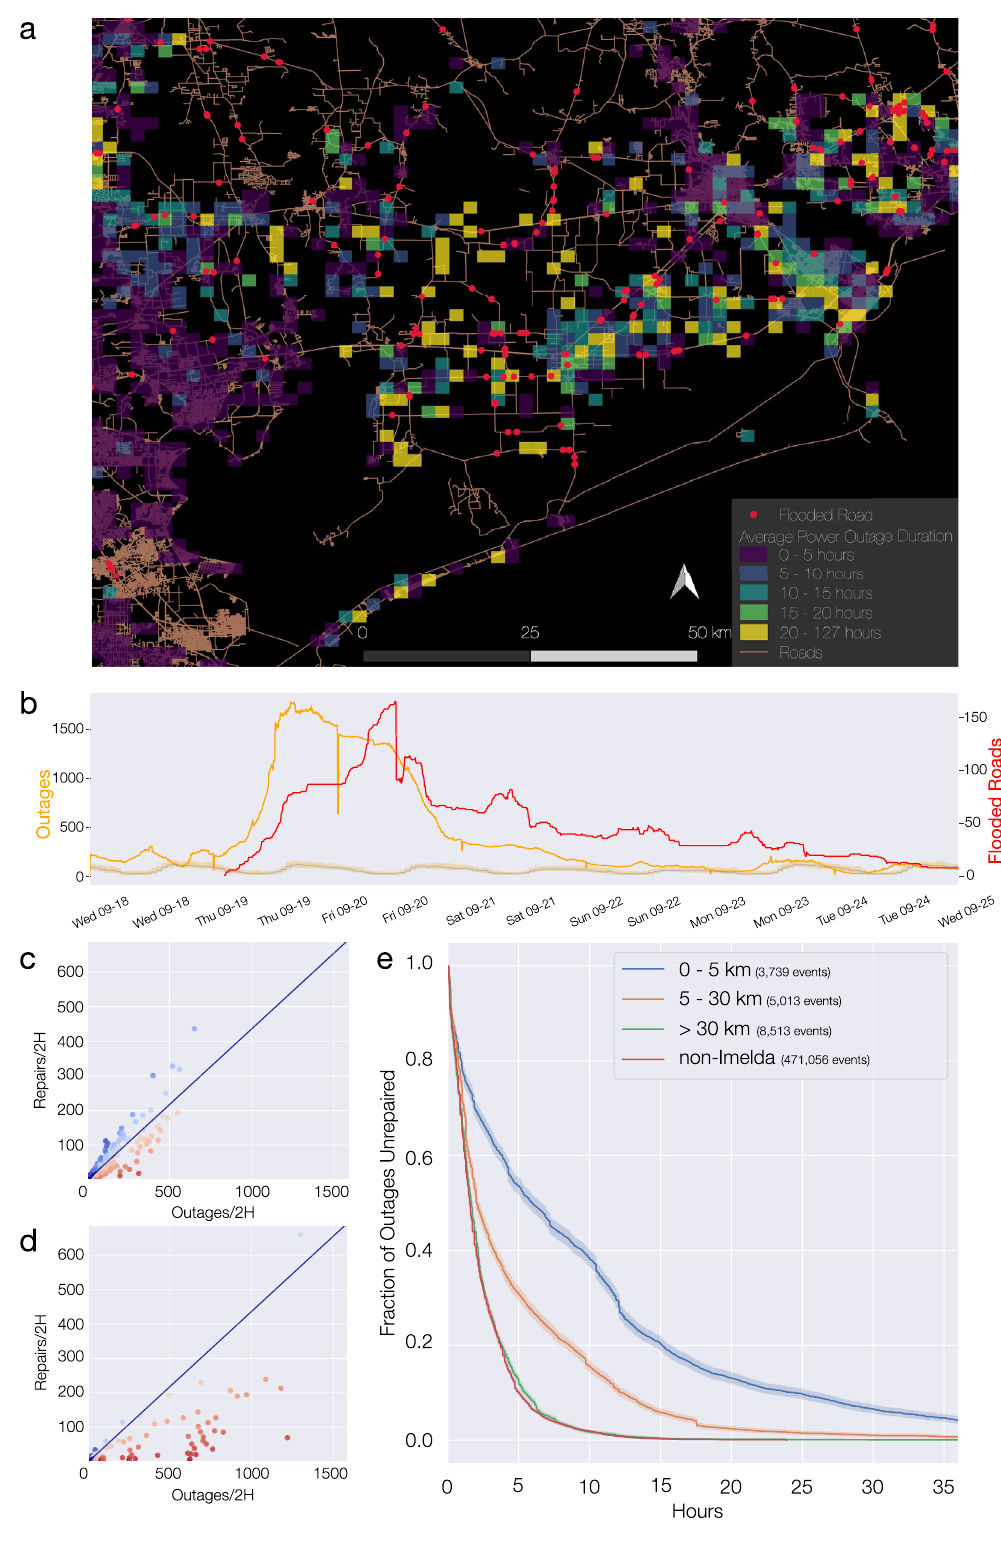
Methods Data . Outage data were collected by taking regular snapshots (several per hour) of the outage maps published by electric utilities around the United States. Each snapshot contains a geotagged list of all outages active at that time, including transmission and distribution outages. A single outage is reported for each inci- dent, even if many customers are affected. By comparing snapshots from moment to moment, and noting the fi rst and last time that the outage appeared, we can